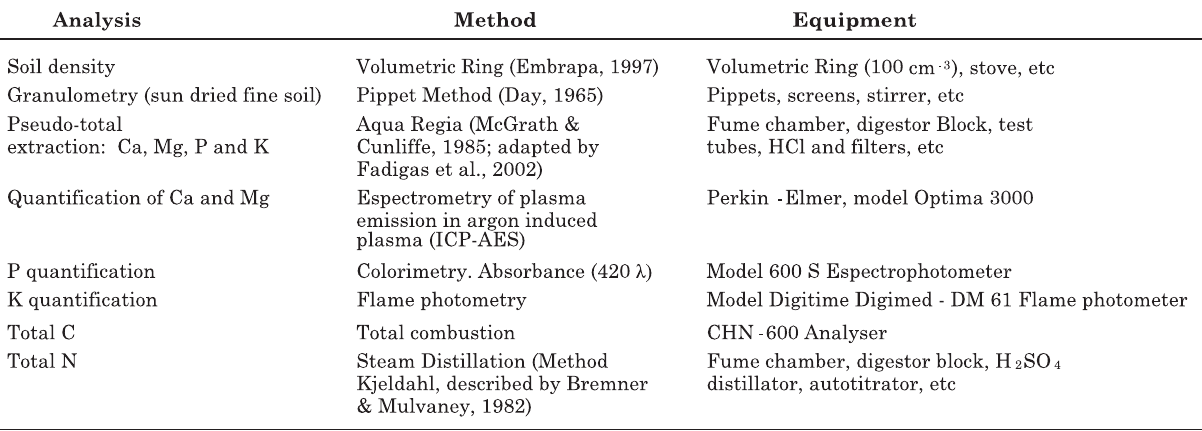
Table 1. Summary of analyses, methodologies and equipment used for the characterization of gully